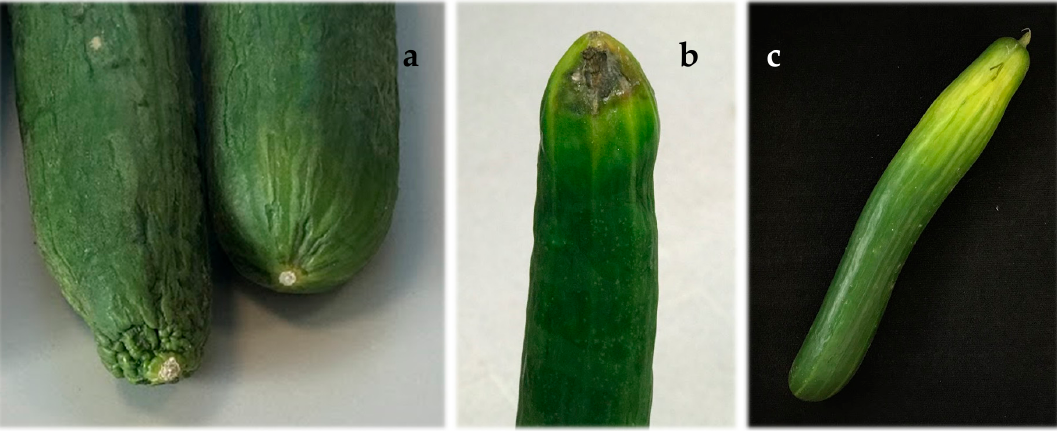
Figure 2. Details of noncommercial cucumber fruits identified during the study. Apical wilt caused by fruit aging and water loss ( a ). Apical rot ( b ). Loss of green color (i.e., chlorophyll) with yellow development ( c ).